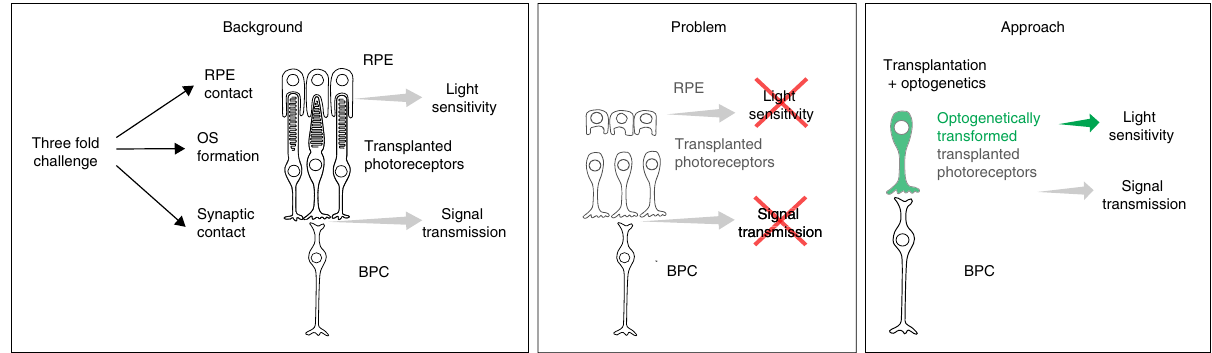
Fig. 6 Schematic illustrating the three-fold challenge in photoreceptor cell replacement. In order to provide visual improvement, transplanted photoreceptors need to form functional OS, retain in close contact to the RPE to maintain light sensitivity, and develop synaptic connection to host bipolar cells for signal transmission. After transplantation into animals with severely degenerated ONL, photoreceptors fail to develop normal OS structure and establish correct polarity with respect to host RPE. In addition, in retinal degeneration, the RPE is often compromised alongside photoreceptors. All this undermines the success of photoreceptor replacement. We therefore introduced a hyperpolarizing microbial opsin into the photoreceptors before transplantation, developing an OS- and RPE-independent approach for vision restoration in late-stage retinal degeneration. RPE — retinal